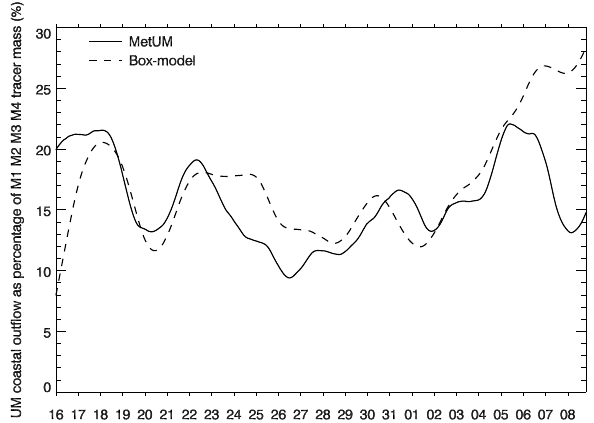
Figure 11. Time series of tracer in the coastal outflow layer as a percentage of M 1 + M 2 + M 3 + M 4 . Comparing the MetUM simulation (solid line) and box model (dashed line) forced with the cross-coastal wind speeds at 850hPa obtained by averaging along the coast and filtering out the diurnal cycle.